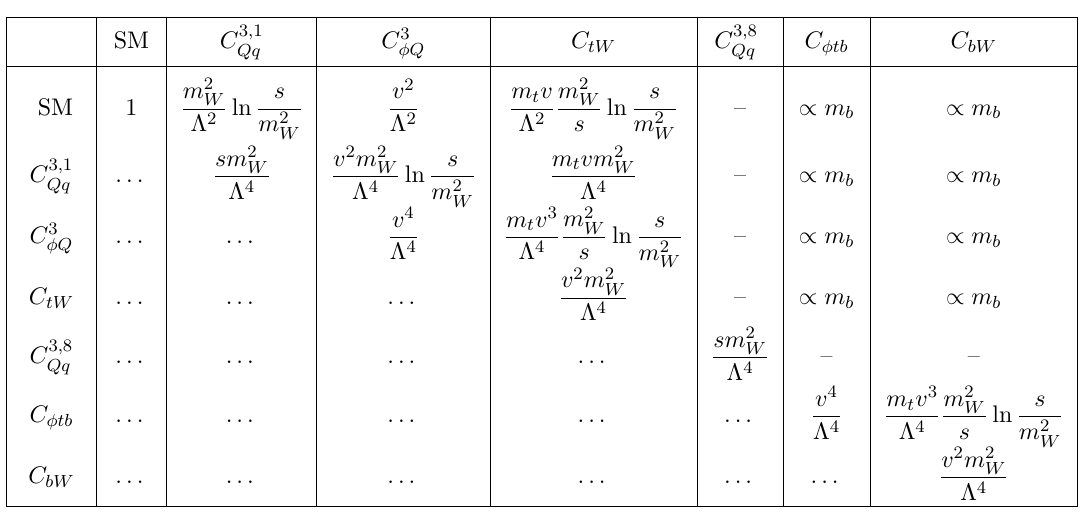
Table 4 . Relative scaling of operator contributions in t -channel single top production at high p energies s (cid:29) m t . The scaling for s -channel production is obtained by replacing m 2 ln( : : : ) ! 1. The SM contribution scales as 1 =m 2